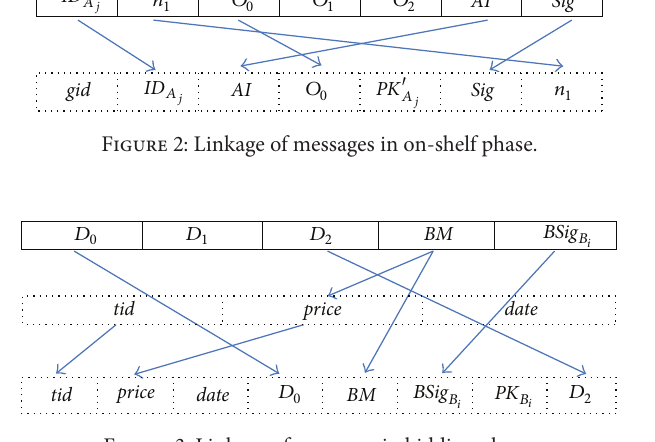
Figure 3: Linkage of messages in bidding